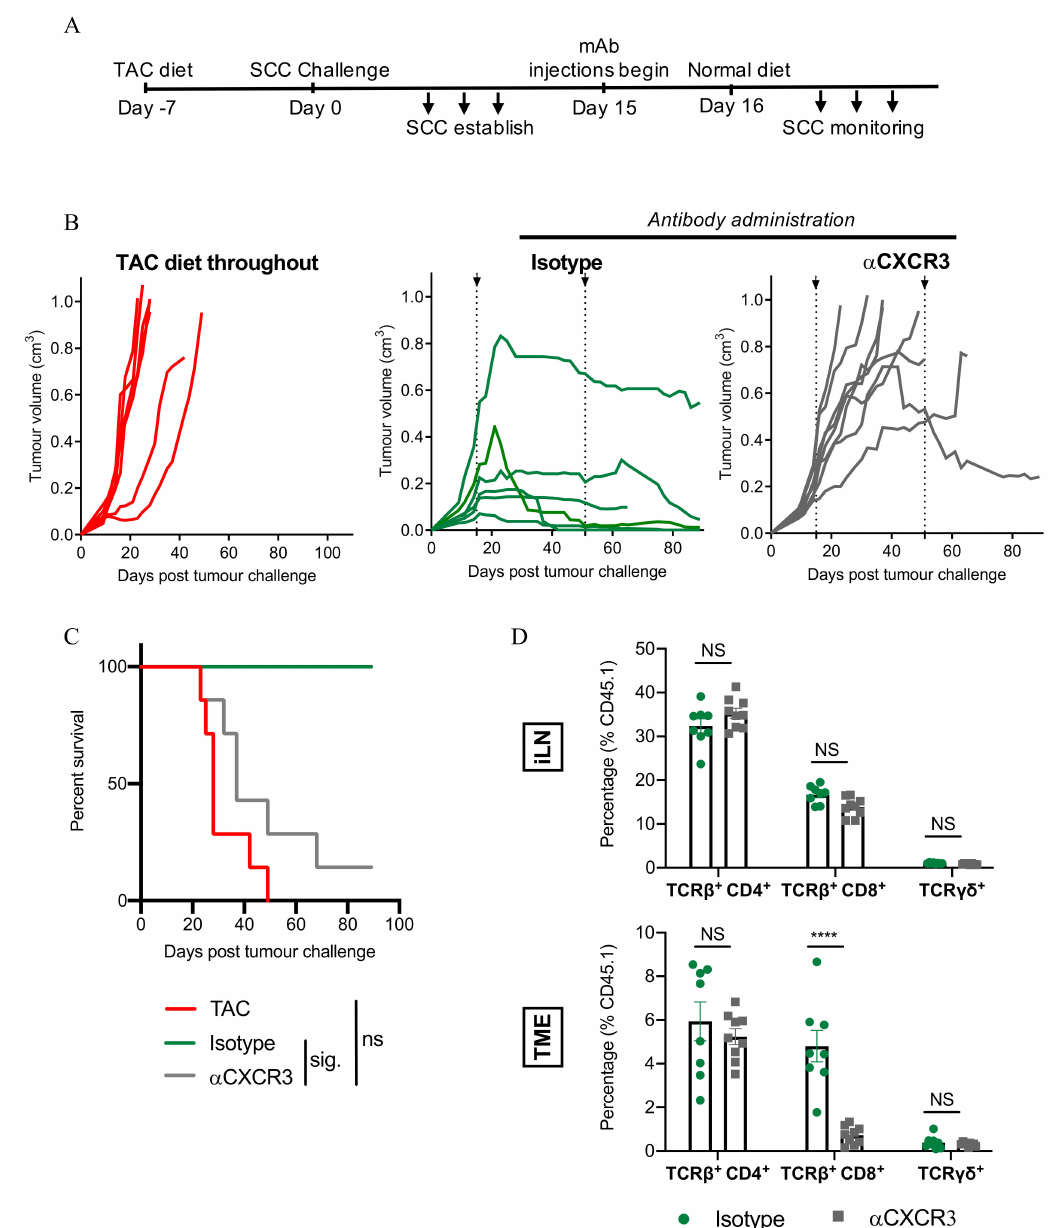
Figure 7. The CXCL10/CXCL11/CXCR3 axis plays a role in SCC regression. ( A ) Experimental schedule. ( B ) SCC growth pattern following treatment with the indicated antibodies. Combined data from 2 independent experiments, individual tumours shown, n = 6–8/group. ( C ) Survival comparisons of mice in B. Survival analyses were performed by Log-rank (Mantel-Cox) test. Results then displayed as significant (sig.) or not significant (ns) after bonferroni-corrected multiple comparison test. Bonferroni-corrected threshold = 0.016, K = 3. ( D ) Abundance of T cell subsets (%) in the inguinal lymph nodes (iLN) or in the tumour microenvironment (TME), as shown. Two-way ANOVA, bars represent mean ± SEM, data points represent individual mice. Data are combined from 2 independent experiments. p < 0.0001 (****), Dotted lines in ( B ) indicate the period of antibody